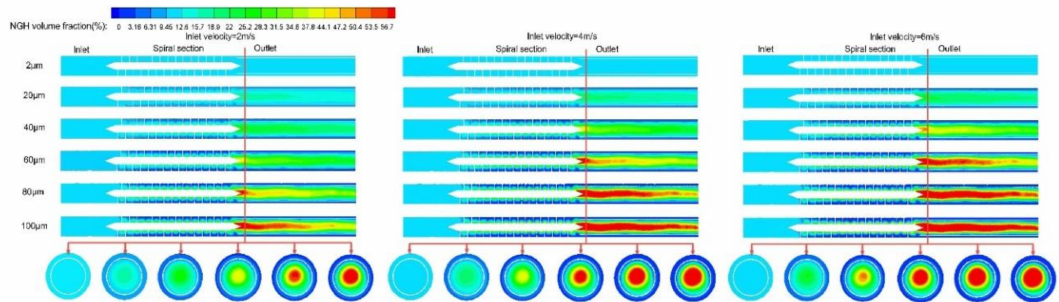
Figure 7. The NGH distribution contours across the horizontal section of the spiral separator and the vertical section at the outlet with di ff erent particle